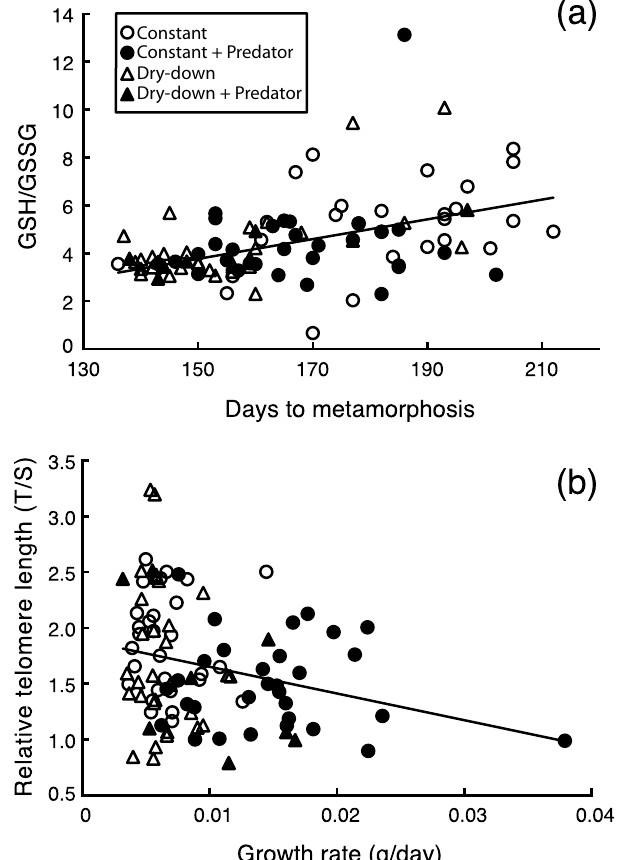
Figure 3. Regressions between ( a ) days to metamorphosis and GSH/GSSG ratio (R 2 = 0.19, P < 0.001) and between ( a ) growth and telomere length (R 2 = 0.07, P = 0.008). Regression lines show the correlation between physiological and life-history traits measured in Pelobates cultripes juveniles surviving all four experimental groups combined: constant water level, constant water level plus predator, dry-down, and dry-down plus predators. Cellular oxidative stress normally results in decreased GSH/GSSG ratio, whereas telomere shortening is a reliable indicator of individual/cellular senescence. The GSH/GSSG ratio increased with increased length of the larval period, whereas telomere length was shortened with increased growth